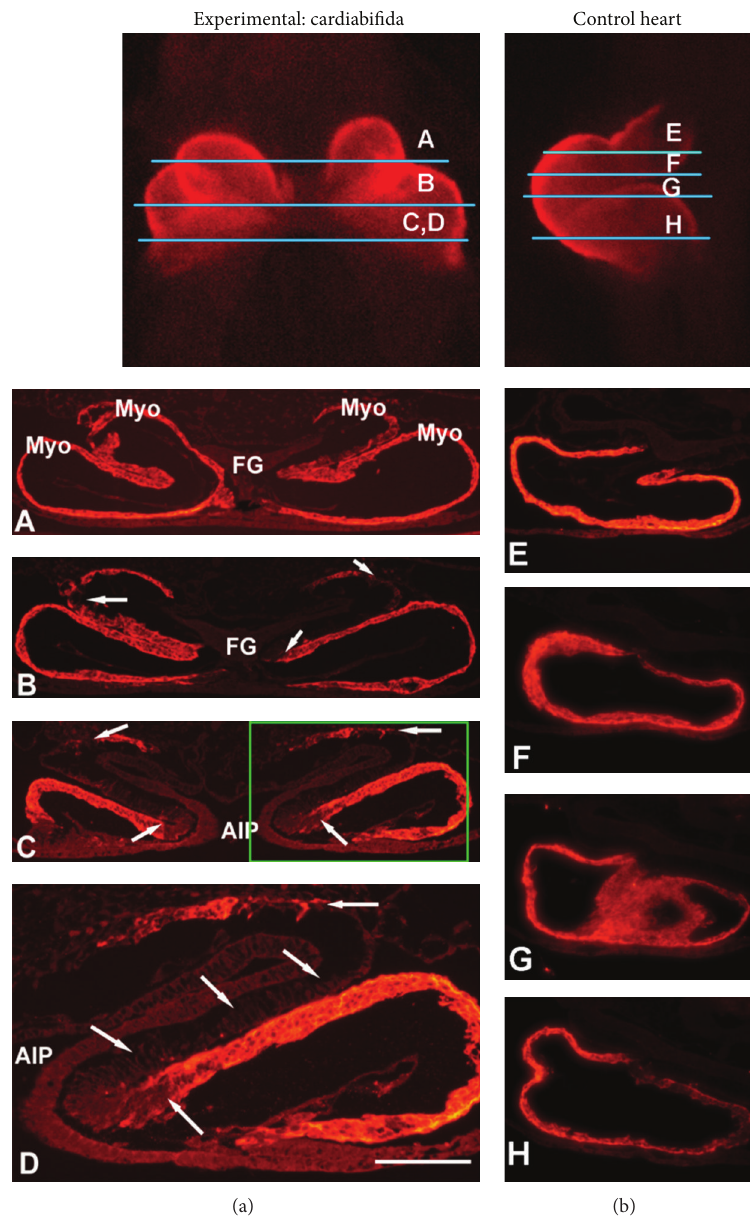
Figure 3: In contrast to the control embryo showing a looping, single tubular heart (right column of figure panels), a lithium-exposed embryo demonstrates a delay in the bilateral heart fields coming together at the midline, and thus a condition of cardiabifida is observed (left column of panels). The experimental, cardiabifida, heart also shows bilateral regions of the heart in which cardiomyocyte differentiation, as defined by MF-20 staining for sarcomeric myosin heavy chain expression, has been suppressed (see areas delineated by white arrows). A–C shows sections through heart from anterior to posterior for the experimental heart. D. A higher magnification of boxed-in region in C is shown here. After the effect of acute environmental exposure dissipates, cardiomyocyte differentiation reappears posteriorly. E–H depict anterior to posterior sections of the control heart. Approximate regions of sections that cut through the heart are shown by lines in the whole mounts of the respective hearts on